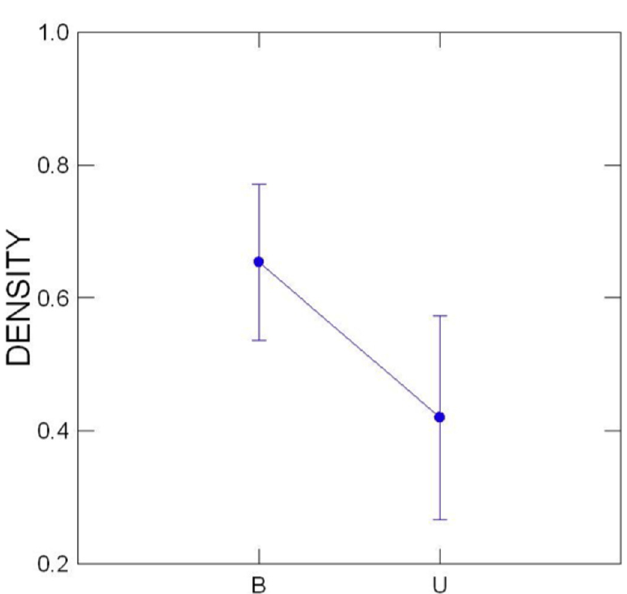
Figure 1. Average burrow density of Red Hills salamanders ( Phaeognathus hubrichti) (number of burrows/ m 2 ) Alabama, USA, with vertical bars extending to the minimum and maximum values, for buffered (B) and unbuffered (U) sites. Buffered sites are those with buffers of at least 10 m of land above and below the sloped site that are protected from forestry